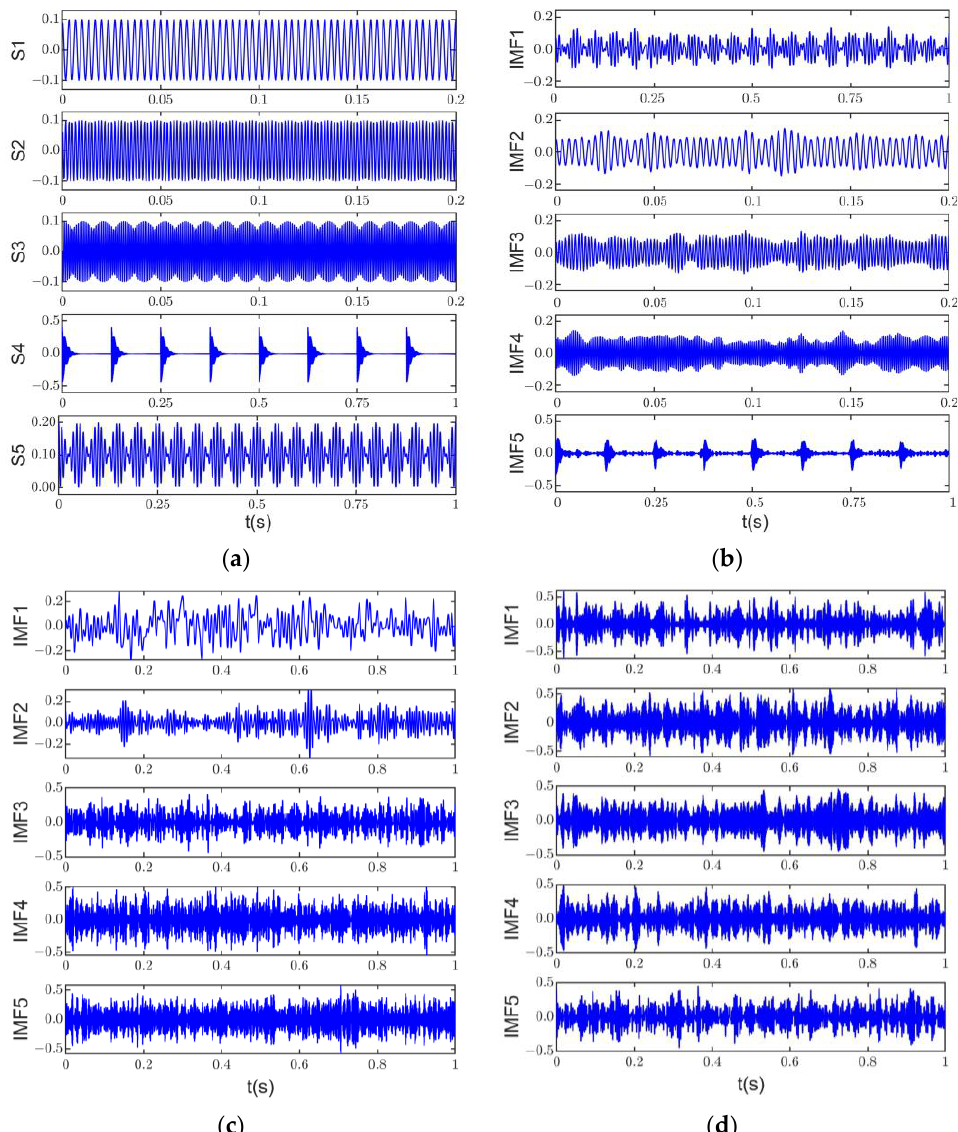
Figure 7. Original signal and decomposition results of three methods: ( a ) original signal, ( b ) ASSME, ( c ) CSSVMD, ( d ) CSSEWT .